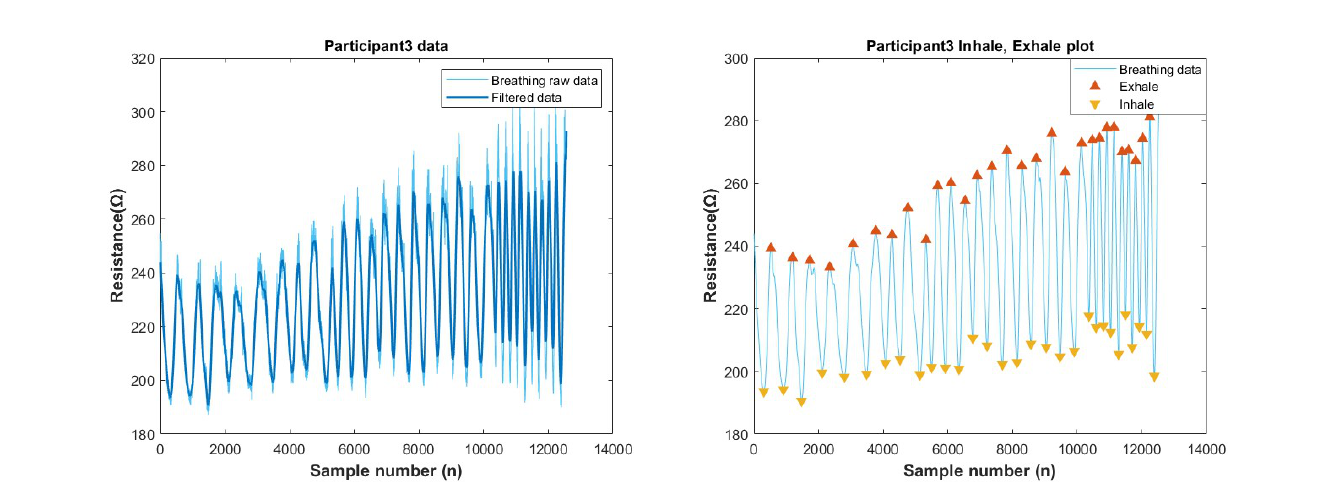
Figure A17. Breathing Test data of Participant number-2.